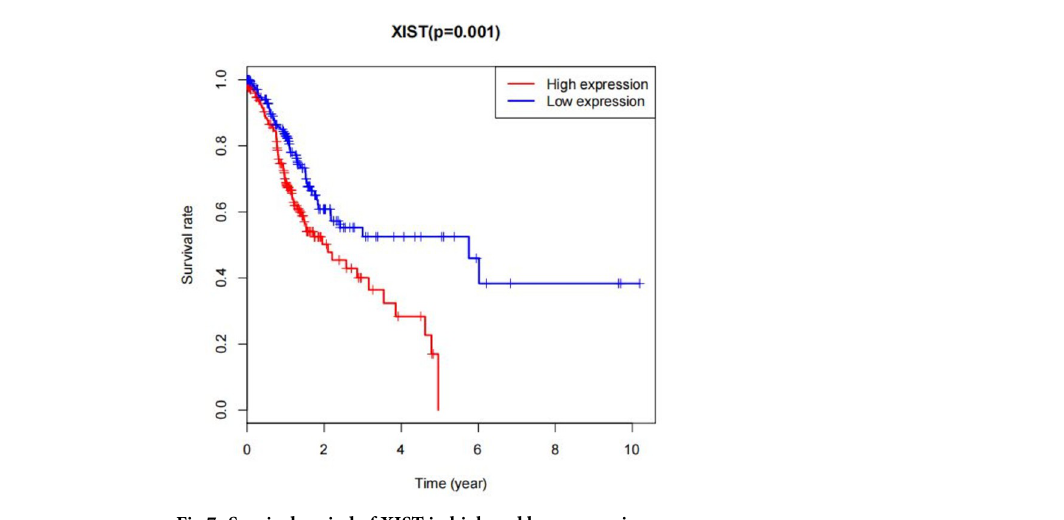
Fig 7. Survival period of XIST in high and low